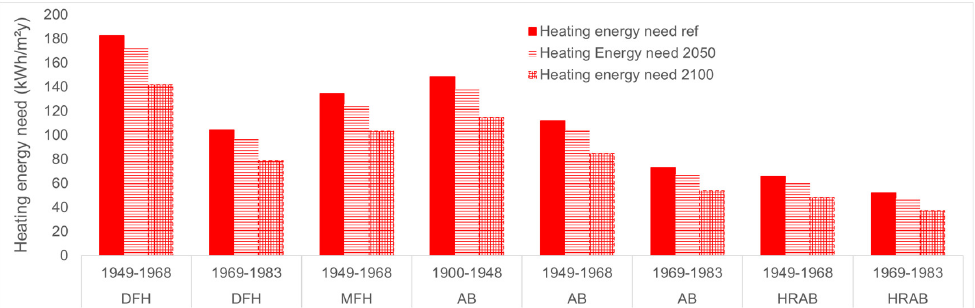
Figure 16. Impact of future climate change on specific cooling energy needs of different building typologies in an urban district in Karlsruhe.